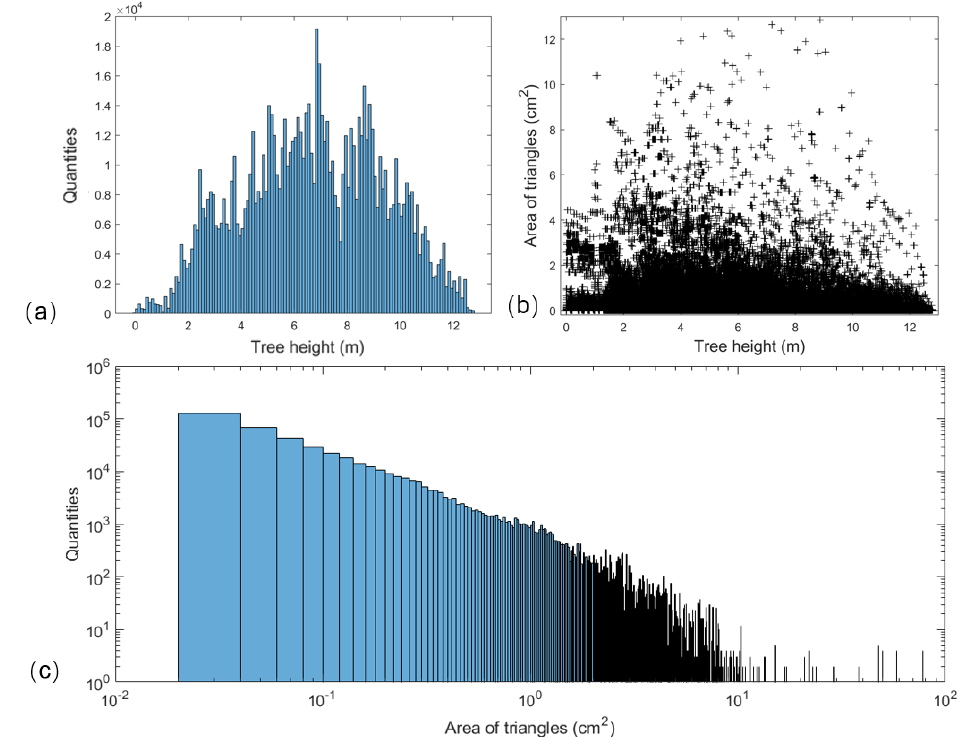
Figure 6. Statistical result of the light condition measurement for the whole tree model; ( a ) the distribution of the triangles’ quantities in tree height; ( b ) the distribution of the area of triangles in tree height; ( c ) The distribution of the triangles’ quantities in triangles’ height; ( c ) The distribution of the triangles’ quantities in triangles’ area.